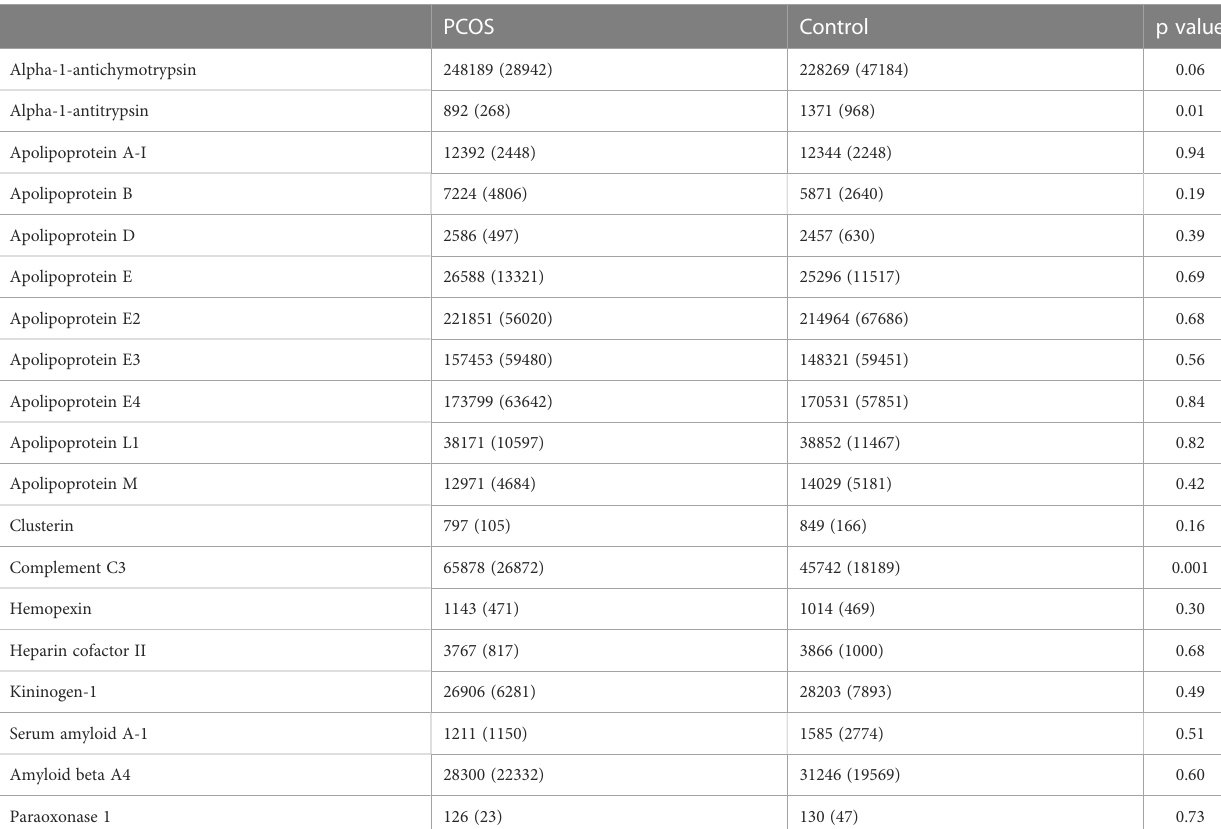
TABLE 2 Levels of proteins involved in lipid metabolism in subjects with polycystic ovary syndrome (PCOS) ful fi lling all three diagnostic criteria versus controls.